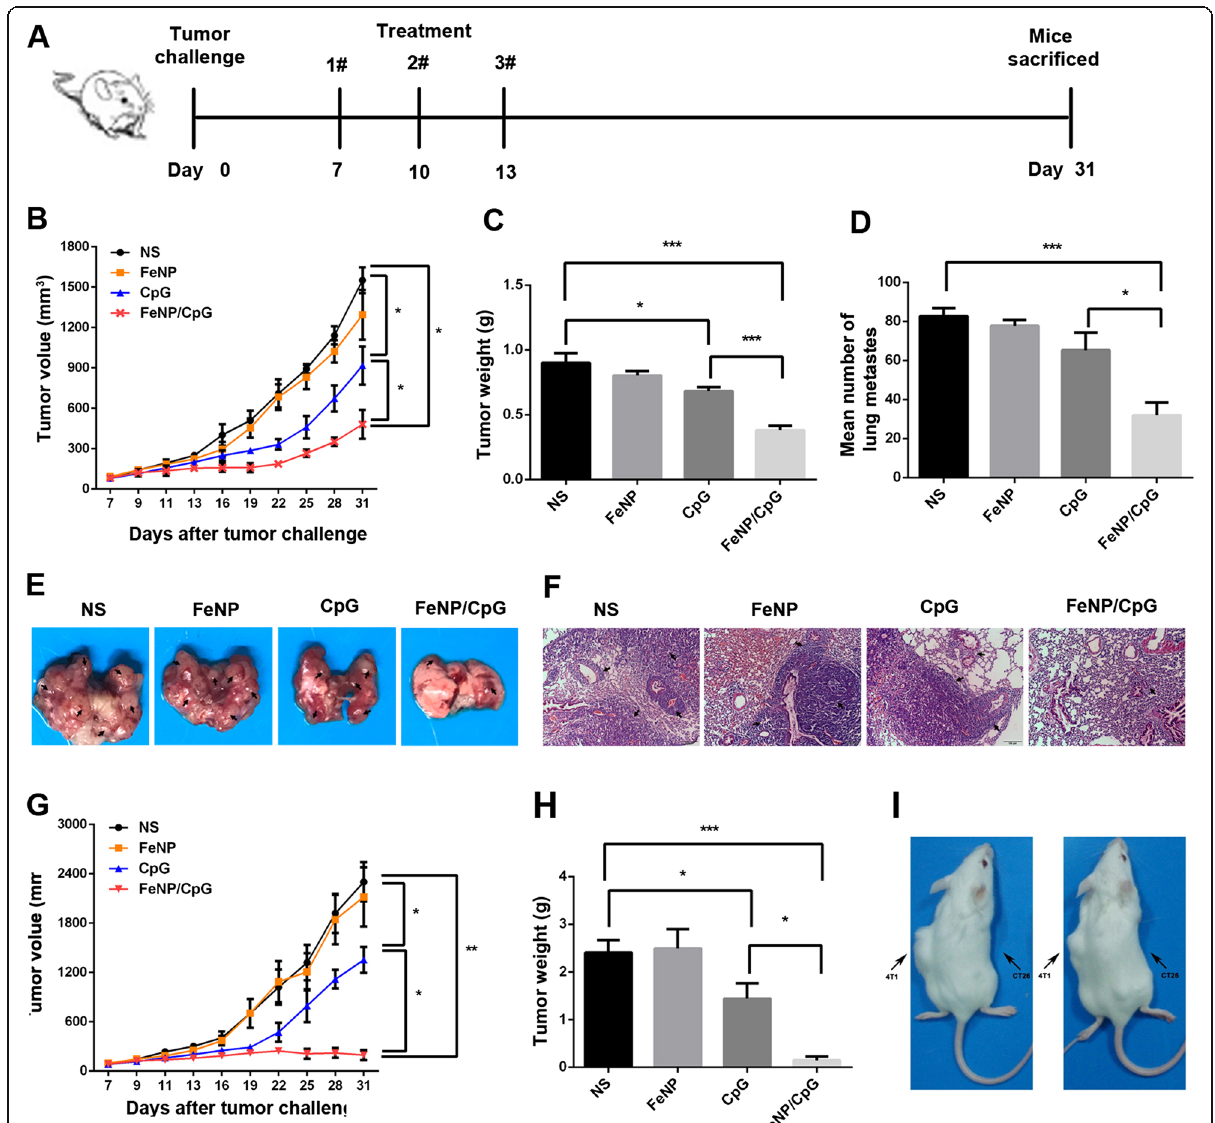
Fig. 4 Antitumor ability of FeNP/CpG particles in vivo. a Treatment schedule of antitumor by FeNP/CpG particles both in C26 colon cancer and 4T1 breast cancer xenograft models through intratumoral injection in vivo. b – d FeNP/CpG particle treatment inhibited the growth of 4T1 tumors. b Representative tumor growth curves of the 4T1 tumor model. c Average tumor weight. d Average lung tumor nodule in each group clearly showing lung metastasis after FeNP/CpG intratumoral injection. e , f Brightfield imaging and H&E staining of the lungs: e The number of visible lung metastases, arrows indicate lung metastases. f H&E staining of the lung metastasis. Scale bars, 100 μ m for H&E staining. g , h FeNP/CpG particles significantly inhibited the growth of C26 xenograft tumors: e tumor growth curves of each group during the experiment and f average tumor weight. There were 10 mice in each group. g Tumor re-challenge experiment. i In C26 model, mice that were cured with FeNP/CpG treatment were re-challenged with 5 × 10 5 C26 (right flank) or 4T1 cells (left flank) s.c. into two separate sites on the opposite side of the flank without further treatment. Images shown are representative mice at 20 days after tumor re-challenge. All data were representative of three independent experiments, the mean ± SEM; * P < 0.05, * P < 0.01, and *** P <